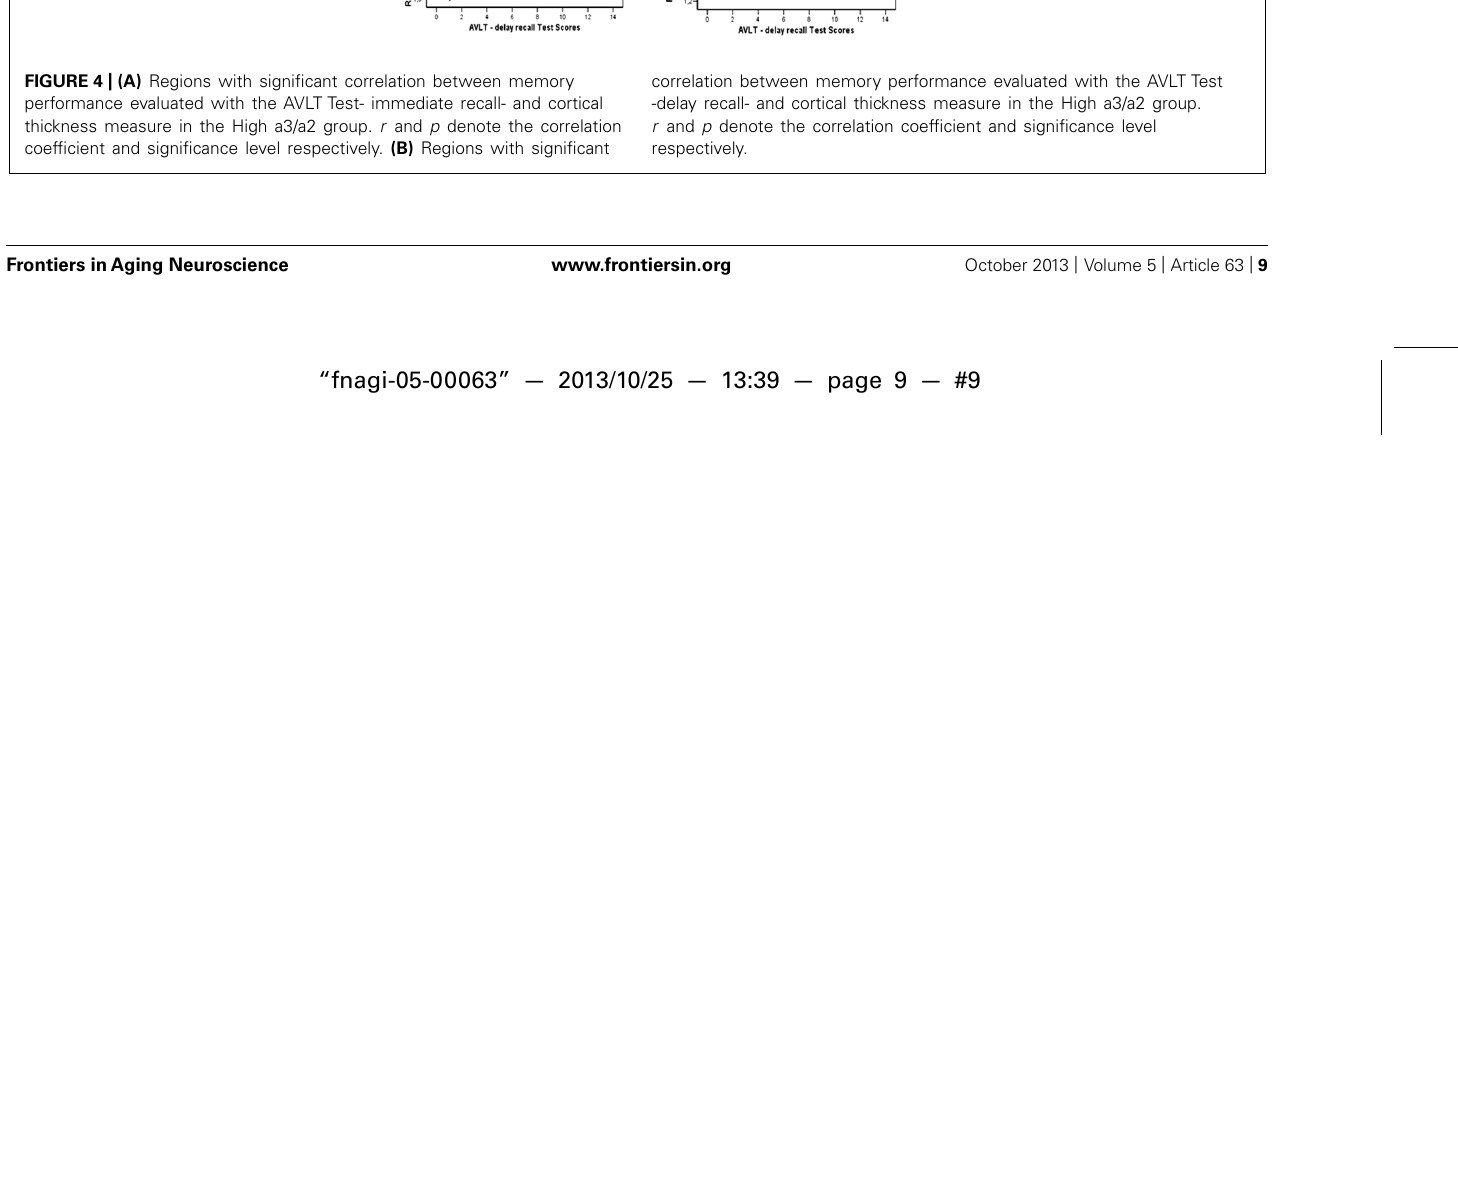
correlation between memory performance evaluated with the AVLT Test -delay recall- and cortical thickness measure in the High a3/a2 group. r and p denote the correlation coefficient and significance level